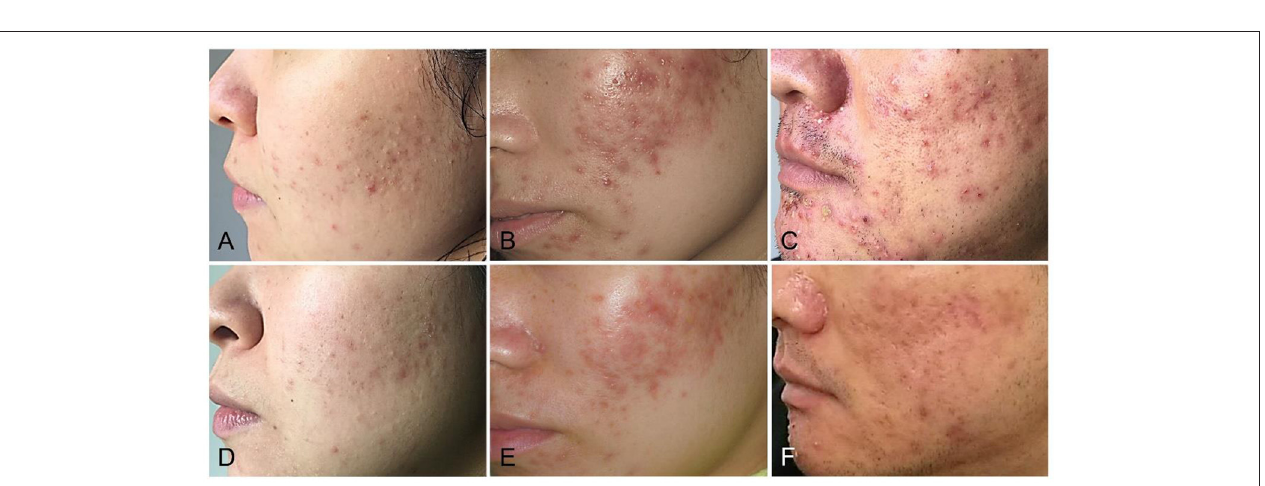
FIGURE 2 | The combined therapy improved the acne condition in patients with mild to severe acne. (A,D) Representative photographs of mild acne patients before and after 2 months of the combined treatment. (B,E) Representative photographs of moderate acne patients before and after 2 months of the combined treatment. (C,F) Representative photographs of severe acne patients before and after 2 months of the combined